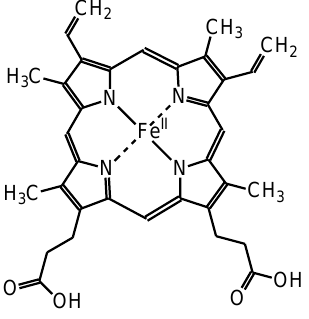
Figure 1. Chemical structure of hem.